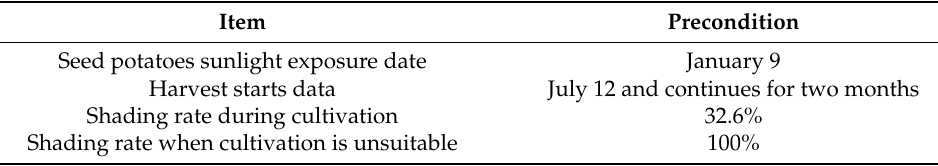
Table 4. Preconditions for discussion added to Table 1.